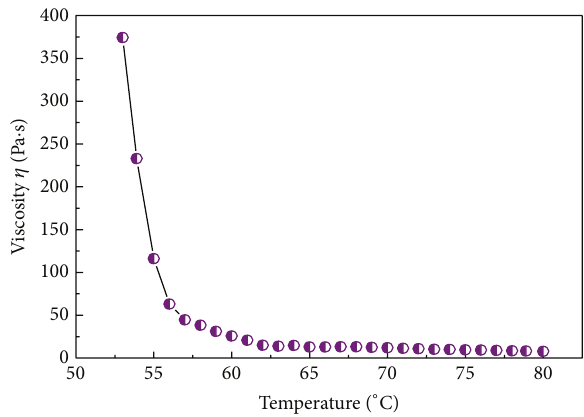
Figure 7: The effect of temperature on viscosity of liquid-like MWNTs.